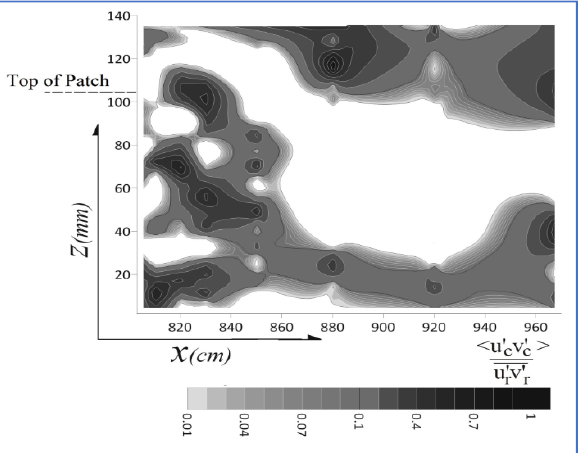
Figure 8. Values of τ c / τ r in the near-bed and near-surface zones; note that the white-colored area is where that no dominant frequency is detectable for velocity time series.